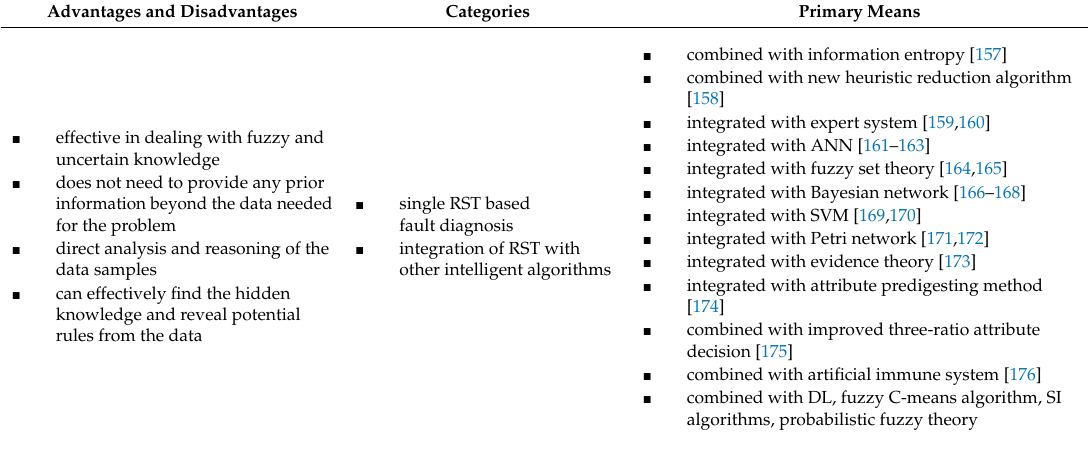
Table 8. A summary for the application of RST in DGA-based transformer fault